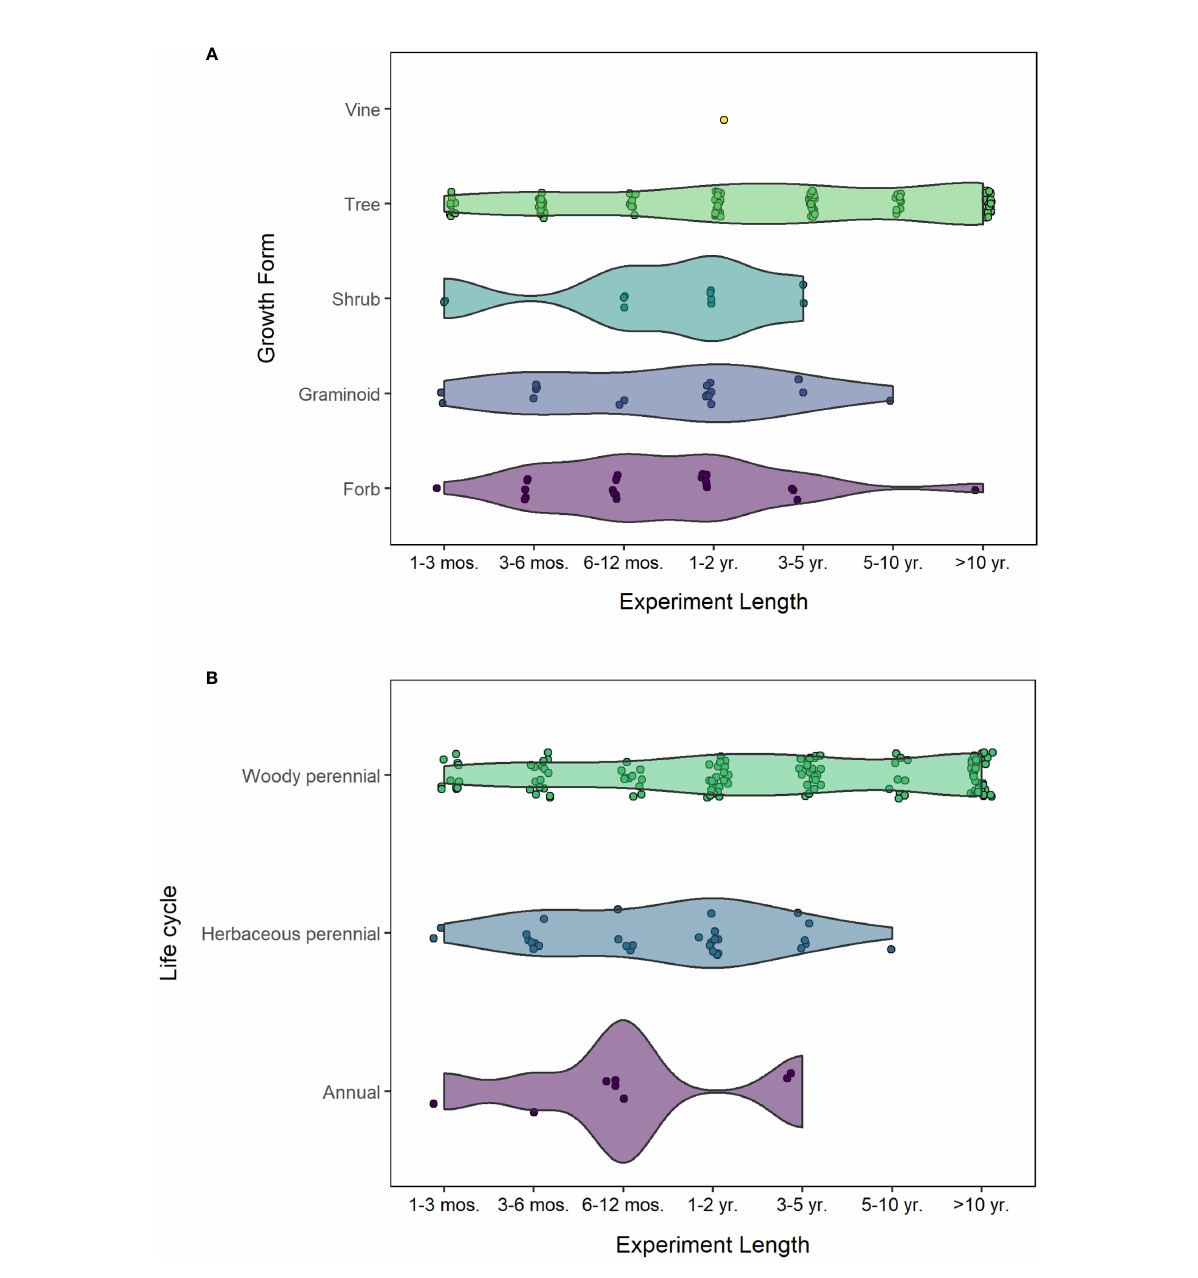
FIGURE 4 (A) Experiment length by plant growth form. Studies of forbs and graminoids are typically between 3 months and 1-2 years in length. Few are 3-5 years in length, and almost none are over 5 years. Whereas woody plants have good representation across experiment lengths (from 1-3 months through >10 years). This is consistent with documentation that many restorations are only tracked for the fi rst few years, despite including many long-lived perennials (15+ years). (B) Number of studies by experiment length and plant life cycle. A single study of an herbaceous biennial is omitted from this